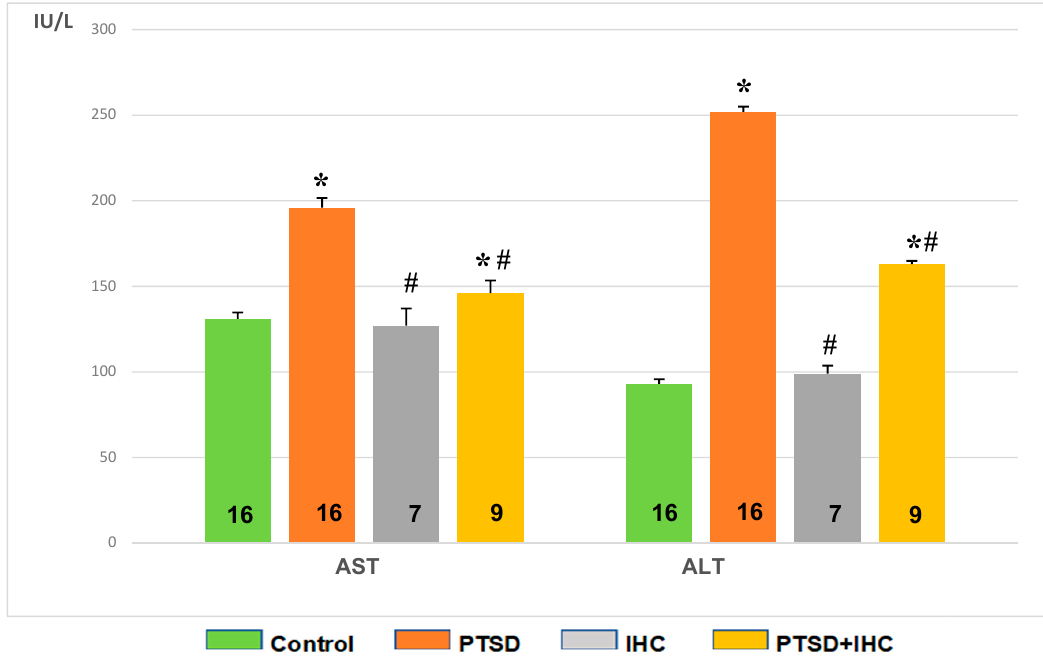
Figure 7. E ff ects of PTSD, IHC, and PTSD + IHC on activities of serum aspartate aminotransferase (AST) and alanine aminotransferase (ALT). PTSD = posttraumatic stress disorder; IHC = intermittent hypoxic conditioning. Data are presented as means ± SEM. Number of rats in groups is shown on the bars. * Significantly di ff erent from control; # significantly di ff erent from PTSD. Specific p values are stated in the